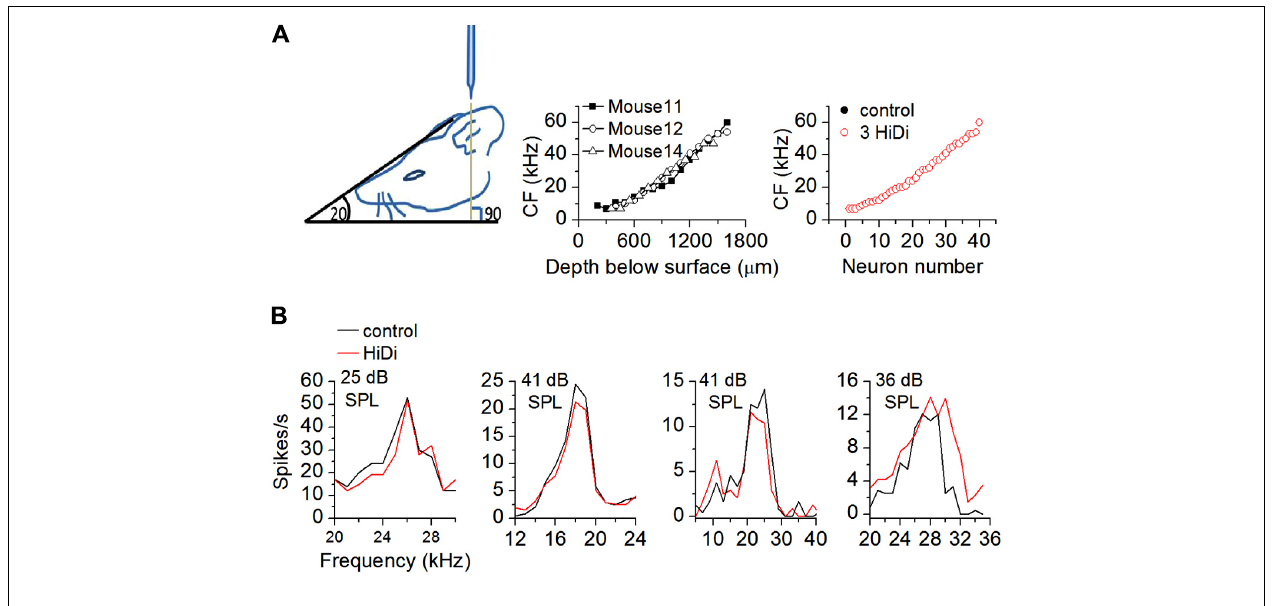
∼ 250 μ m spanning the external and dorsal cortices. Right: sample of 40 neurons showing overlap of CF in control and HiDi ( p = 1).The black and red circles overlap exactly. (B) Tuning curves are unaffected by 2.5 HiDi. Four cells are shown.Thresholds are indicated in each panel. From left to right: ANOVA: cell 1: 21–29 kHz; p = 0.41; cell 2: 12–22 kHz; p = 0.52; cell 3: 6–32 kHz; p = 0.37; cell 4: 20–34 kHz; p =